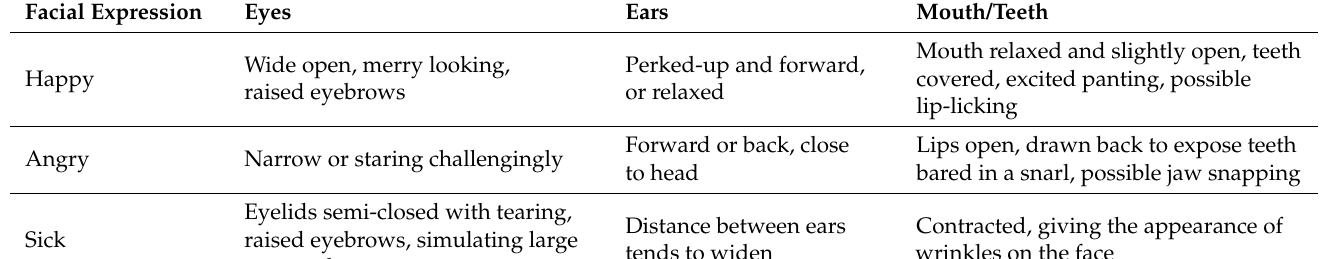
Table 1. Dog facial expressions (happy, angry, and sick) characteristics [49].